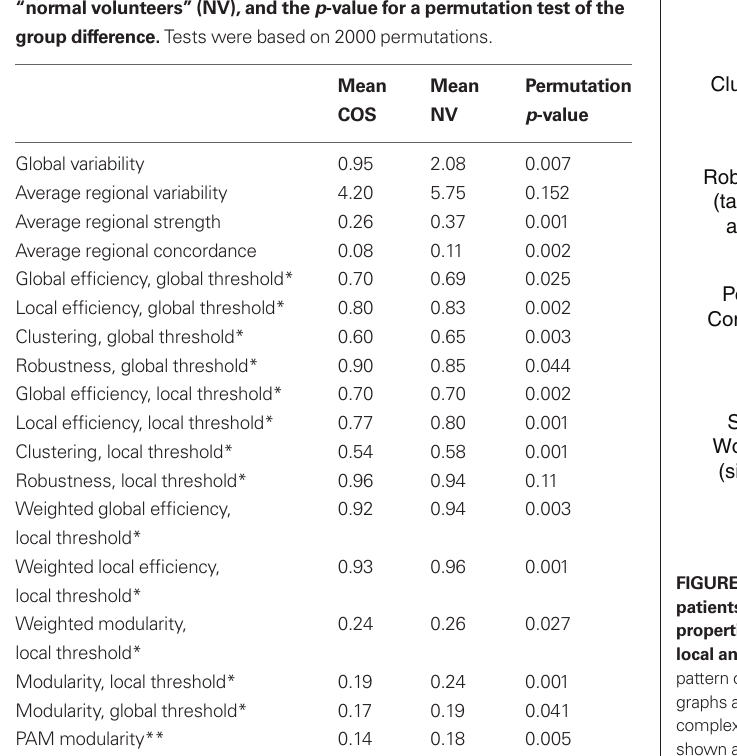
*For the statistics based on thresholded graphs, the values are the mean over the cost range 0.3–0.5. **PAM modularity is summarized as the mean regional silhouette width, averaged over partitions with 2, 3, and 4